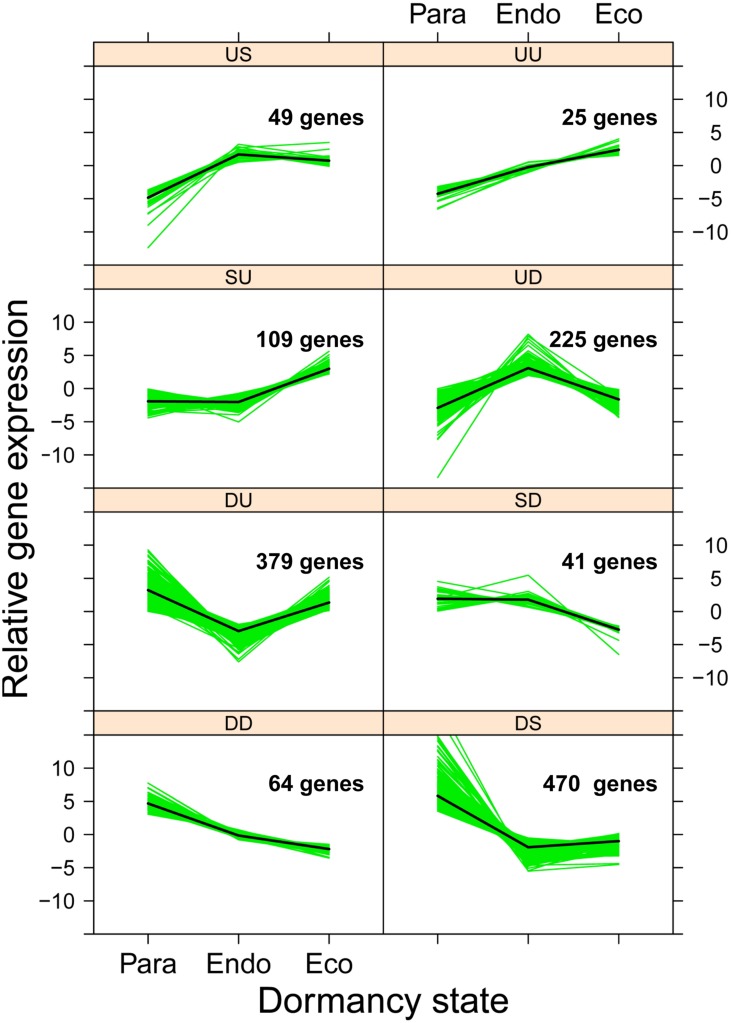
Expression patterns of 1,362 genes that were differentially expressed among dormancy states. Genes were classified into eight gene expression patterns associated with two dormancy transitions: paradormancy to endodormancy and endodormancy to ecodormancy. For each transition, gene expression was either up-regulated (U), the same (S), or down-regulated (D). Solid green lines represent the mean normalized expression for each gene, and the solid black lines represent the mean expression of all genes shown in the panel (i.e., gene expression group).